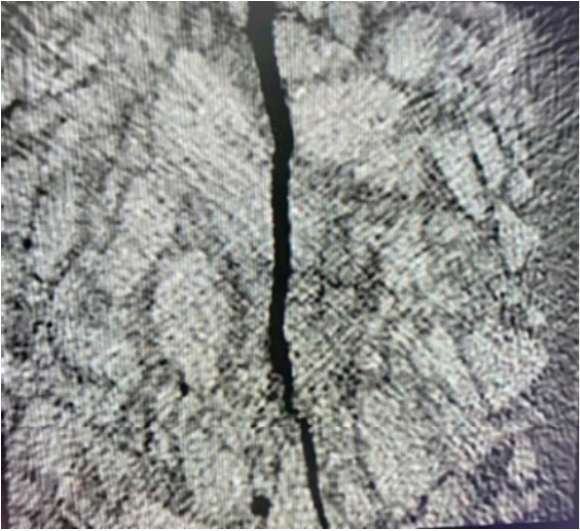
Figure 14. The CT scanning images of the middle part of the unburned concrete standard test block after impacting (150 × 150 mm size).